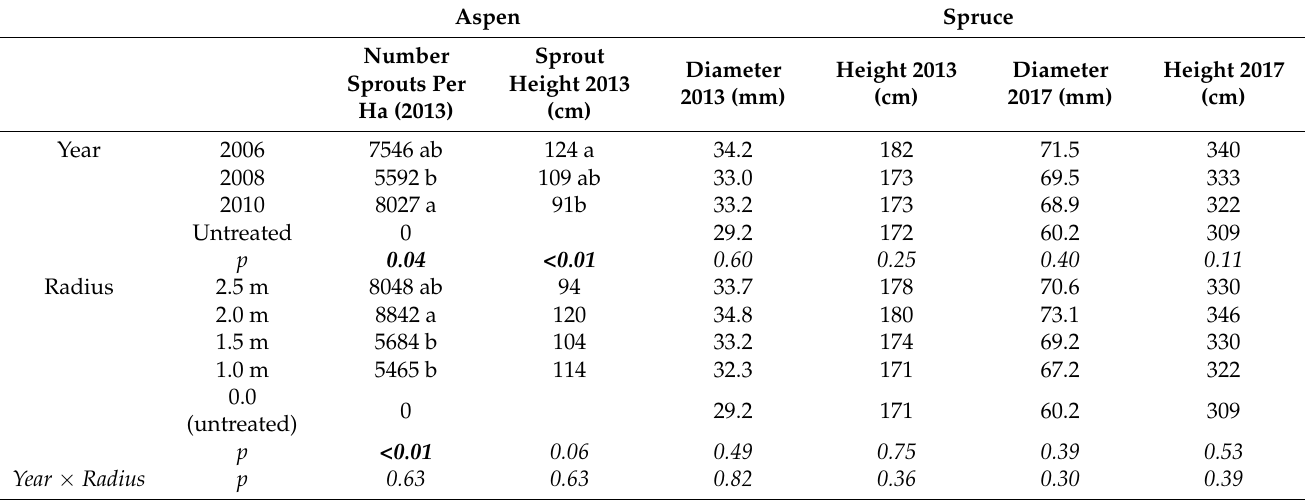
Table 6. Results from analysis of Lac LaBiche blocks as a factorial experiment showing means and Scheffe Groupings for each factor. Significant p values ( α = 0.05) are shown in bold. Letters in each column indicate significant differences detected using Scheffe’s Test at α =